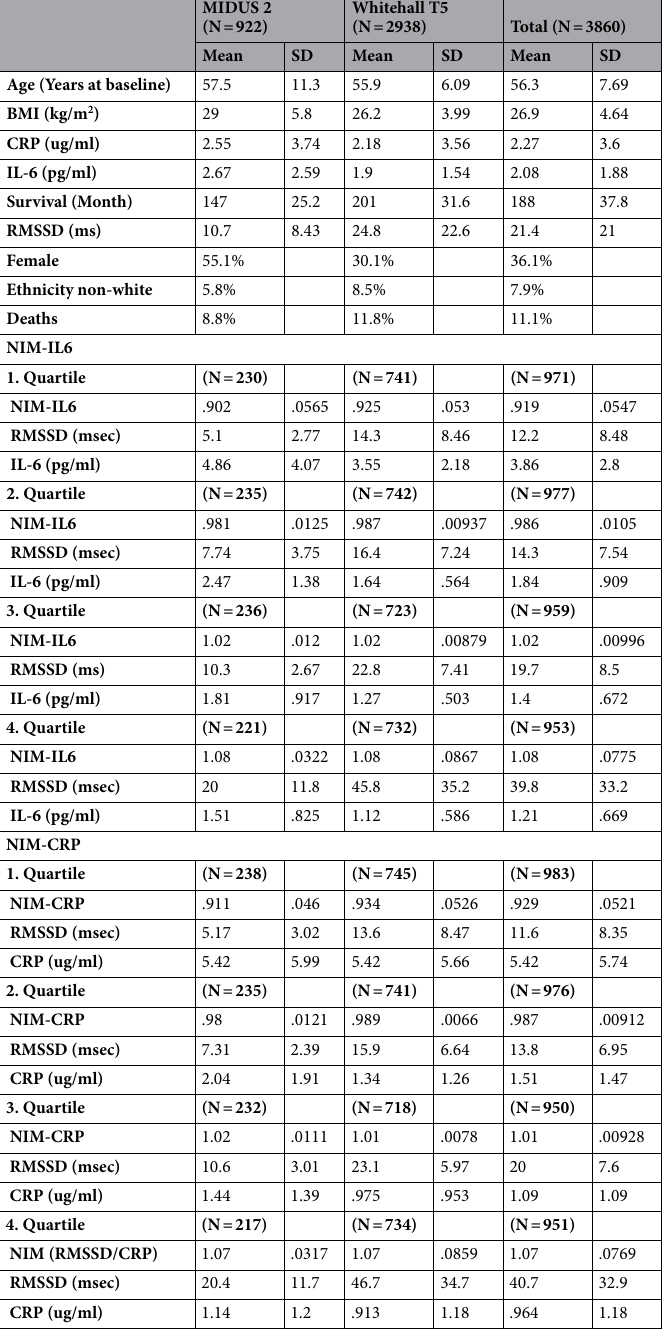
Table 1. Descriptive statistics by